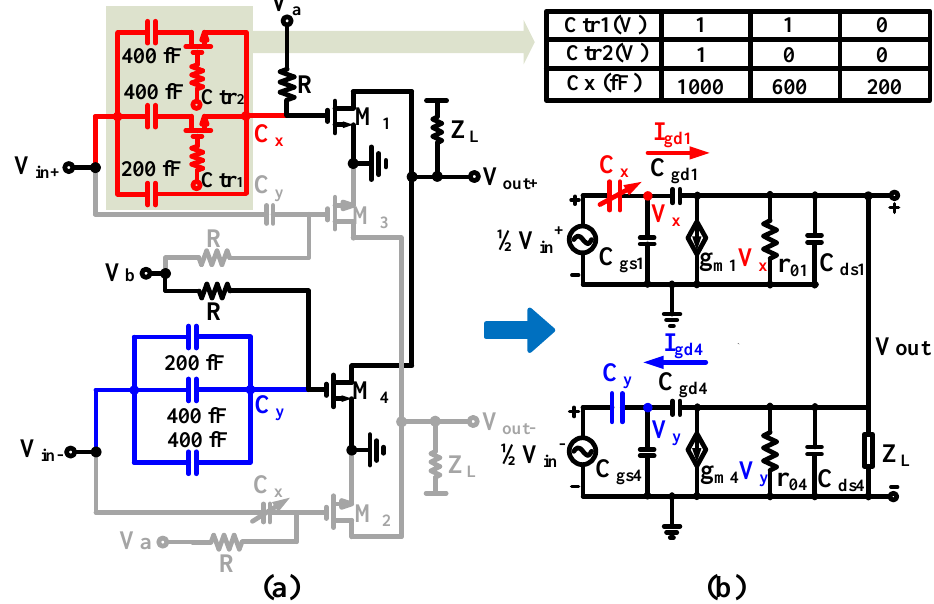
Figure 3. ( a ) Simplified schematic of the proposed variable gain stage and ( b ) its half-side small-signal equivalent circuit.